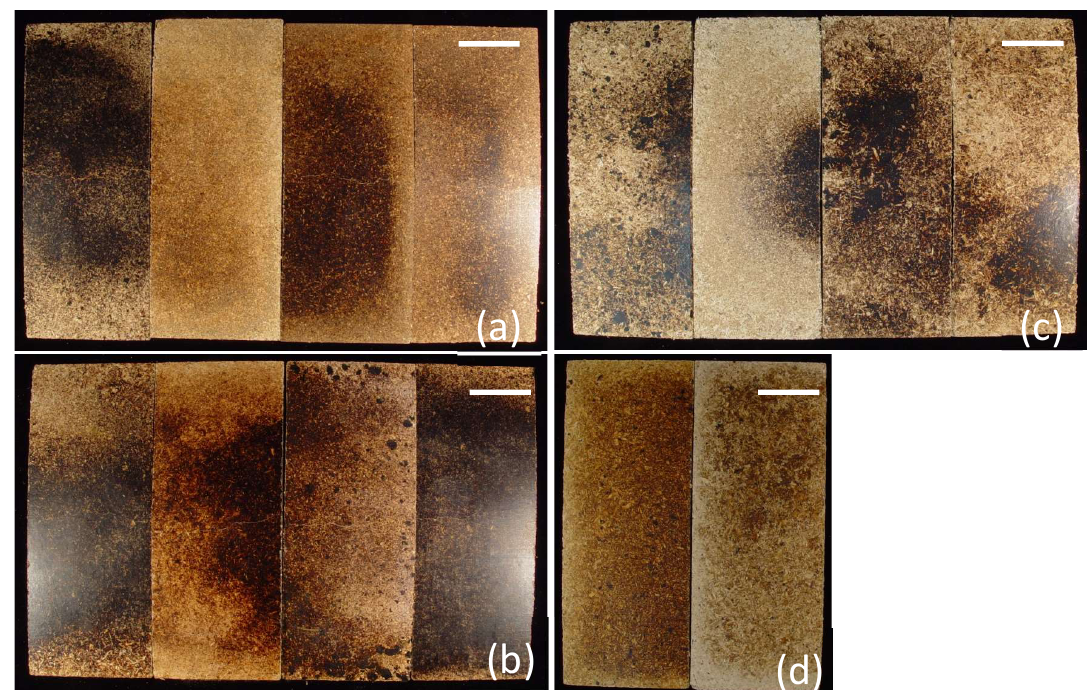
Figure 1. Examples of composite panels employed in flexural testing. ( a ) from left to right: DDGS-PW, DDGS/E-PW, DDGS/CO 2 -PW, and DDGS/H-PW; ( b ) from left to right: LPC-PW, LPC/E-PW, LPC/CO 2 -PW, and LPC/H-PW; ( c ) from left to right: PPC-PW, PPC/E-PW, PPC/CO 2 -PW, and PPC/H-PW; ( d ) from left to right: SBM-PW and SPI-PW. Bar = 25 mm.